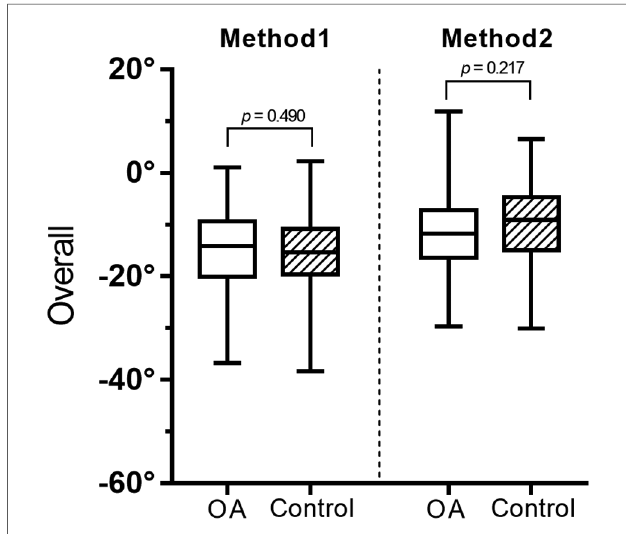
FIGURE 2 Absolute difference between methods 1 and 2 by a box-whisker plot. OA, osteoarthritis; Abs Δ , absolute difference.